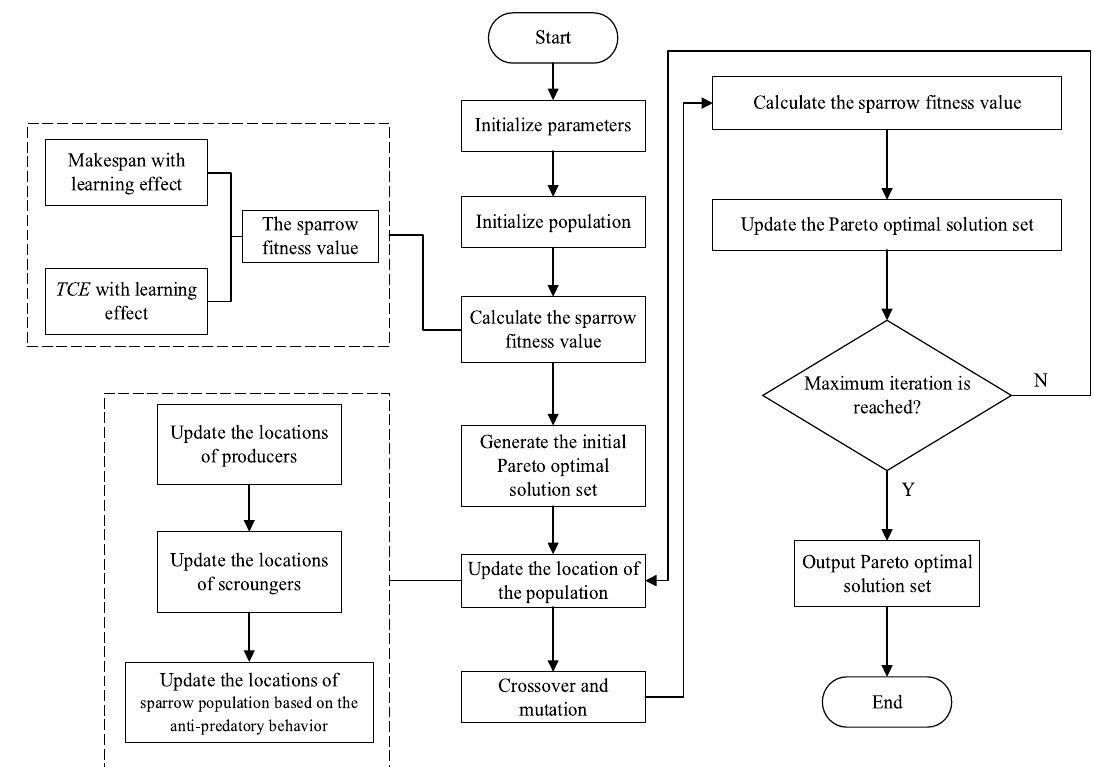
Figure 1. IMOSSA procedure for minimizing the makespan and TCE in the GFJSP with the learning